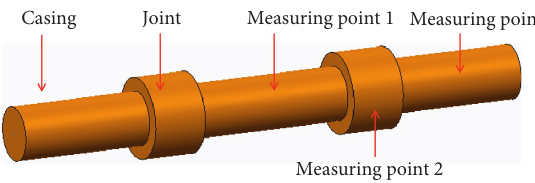
Figure 10: Selection of experiment position.